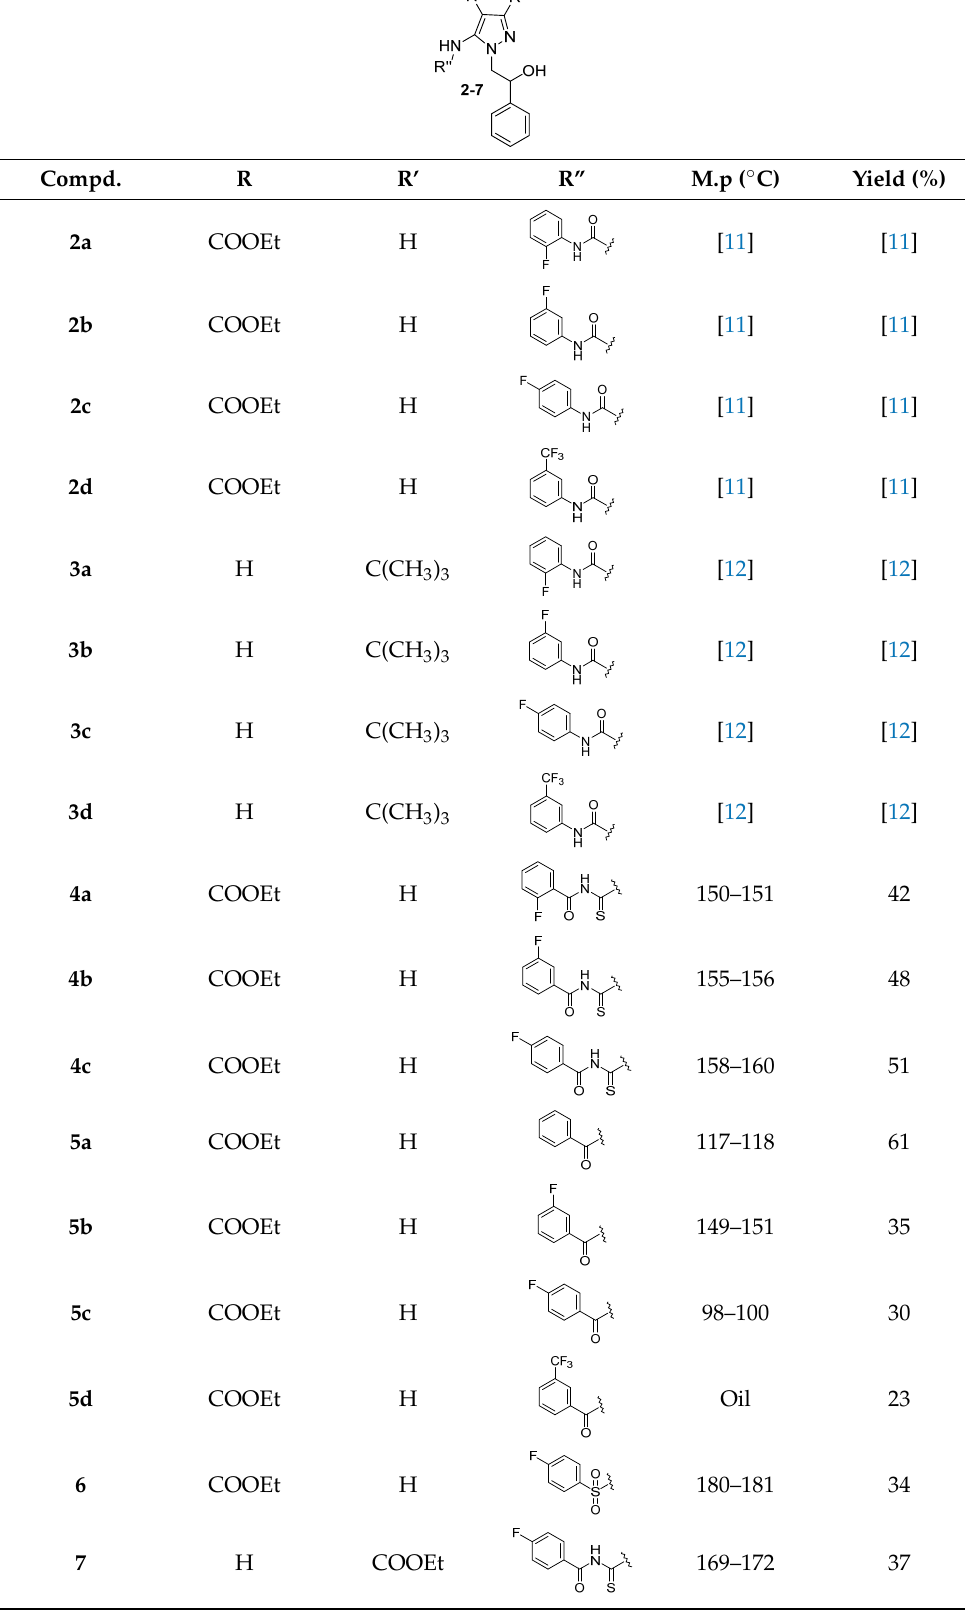
Figure 2. Workflow of the applied strategies leading to the design, biological evaluation and future development of novel pyrazole compounds 2 – 7 . Table 1. Chemical structure, melting point and reaction yield of new pyrazole derivatives 2 – 7 .